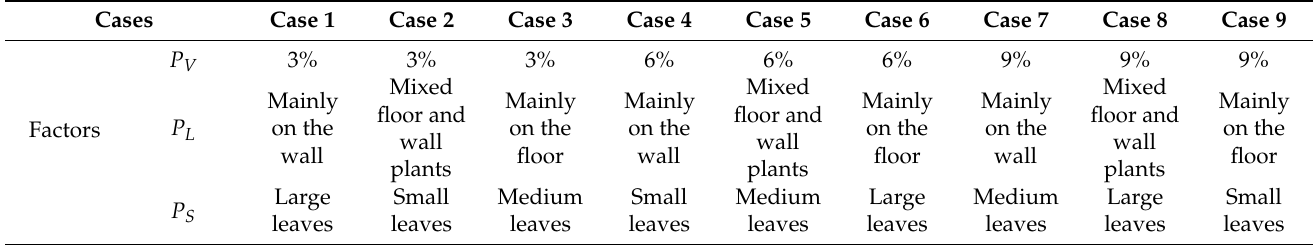
Table 2. L9 (3 × 4) orthogonal table of experimental